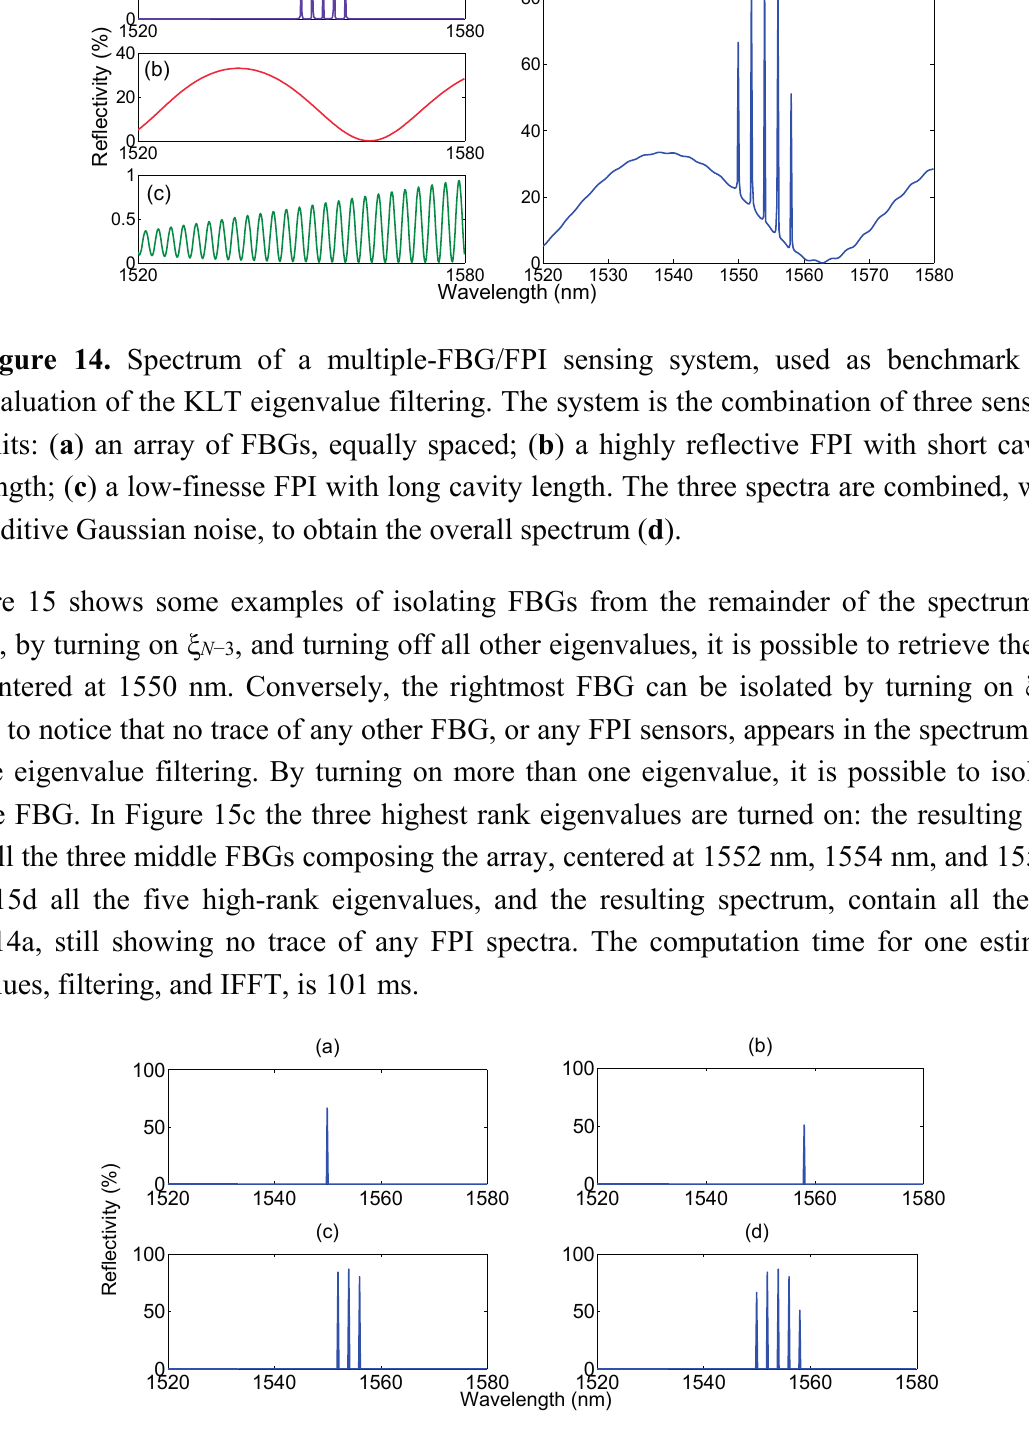
Figure 15. The eigenvalue filtering allows retrieving the FBG profile from the combined spectrum. From the original spectrum in Figure 14d, by means of eigenvalue filtering in Equations (7)–(10), the spectrum of one or multiple FBGs is retrieved. The chart shows four reconstructed spectra, obtained turning on one or more eigenvalues within ( N − 4) and N and turning on all the other ones. The active eigenvalues are: ( a ) ξ N − 3 ; ( b ) ξ N − 4 ; ( c ) ξ N , ξ N − 1 , and ξ N − 2 ; ( d ) all eigenvalues from ξ N − 4 to ξ N